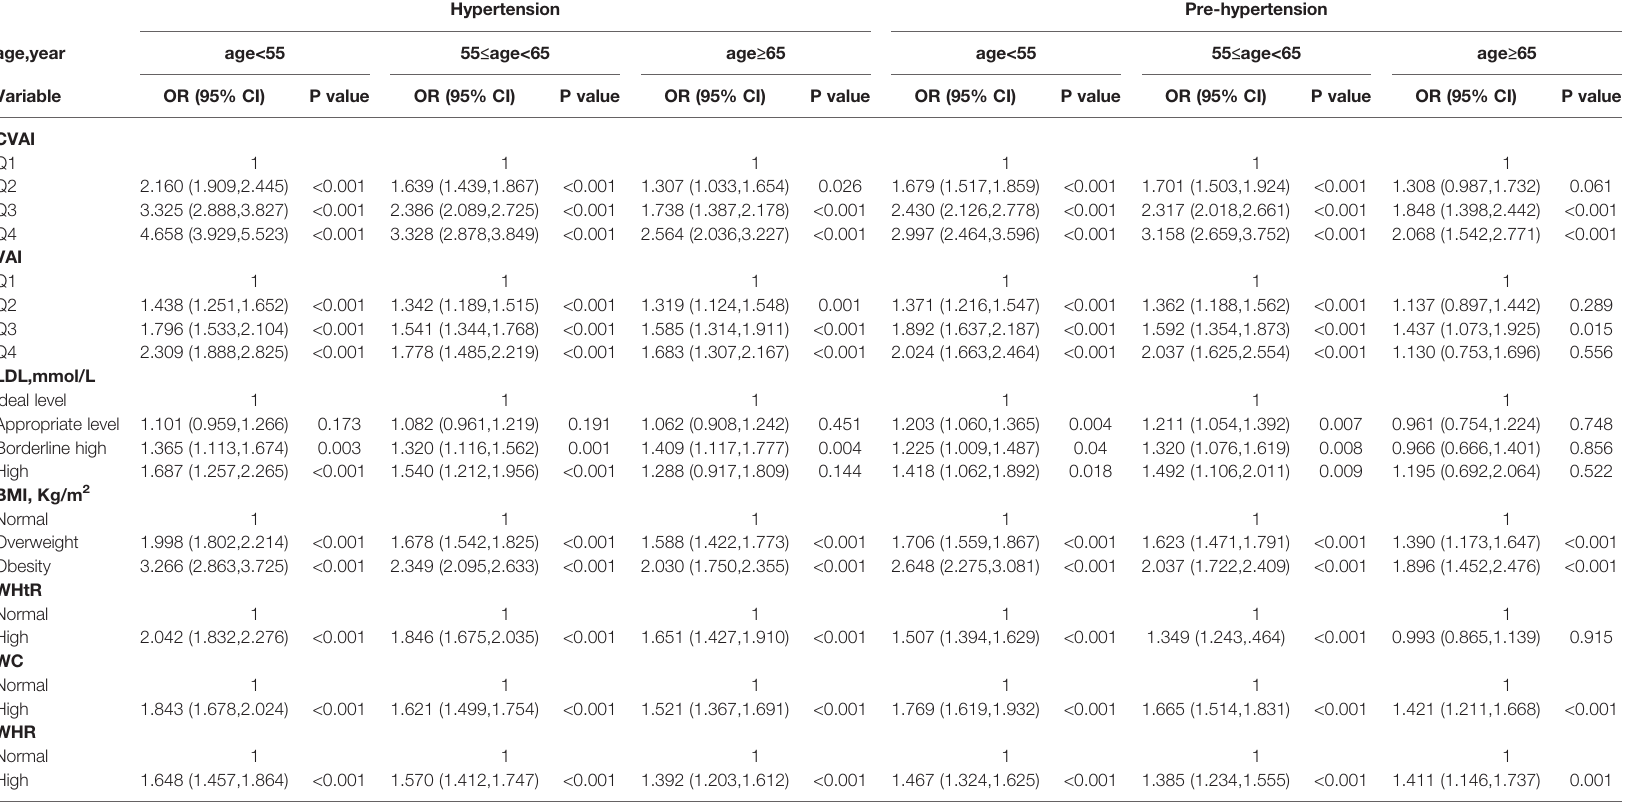
TABLE 5 | Association of CVAI, VAI, BMI, WC, WHtR, WHR and LDL-C with hypertension and prehypertension by